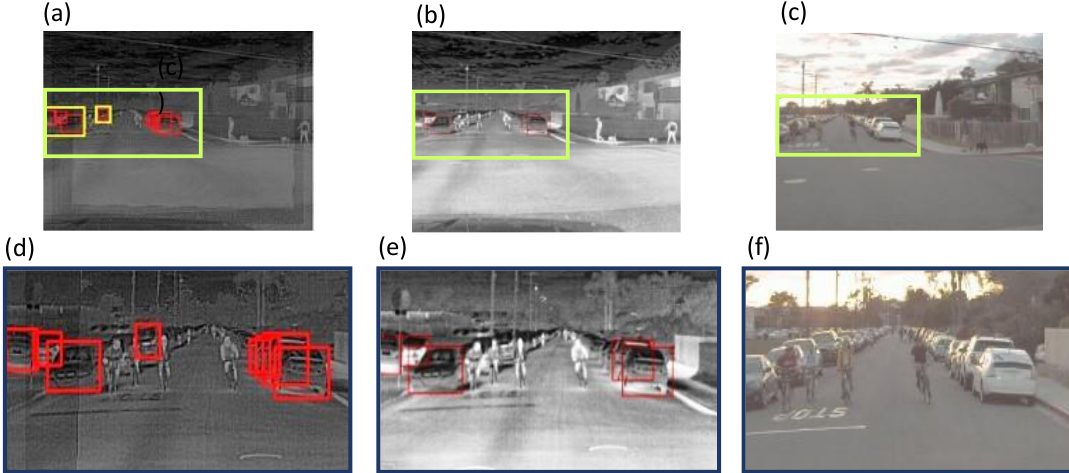
Figure 10. Image FLIR_06423: example of dual images multi-resolution effects on classifying cars in day images. A subsection marked in network classification of the RXD Anomaly Fusion image ( a ), GT image ( b ), and original RGB image ( c ), with light green boxes that are zoomed in to the region of interest, shown in images ( d , e , f ), respectively. The three marked BBs on the left of the GT (b) are out of the frame of the RGB image ( c ). The proposed pre-processing enables the network to detect these objects correctly.